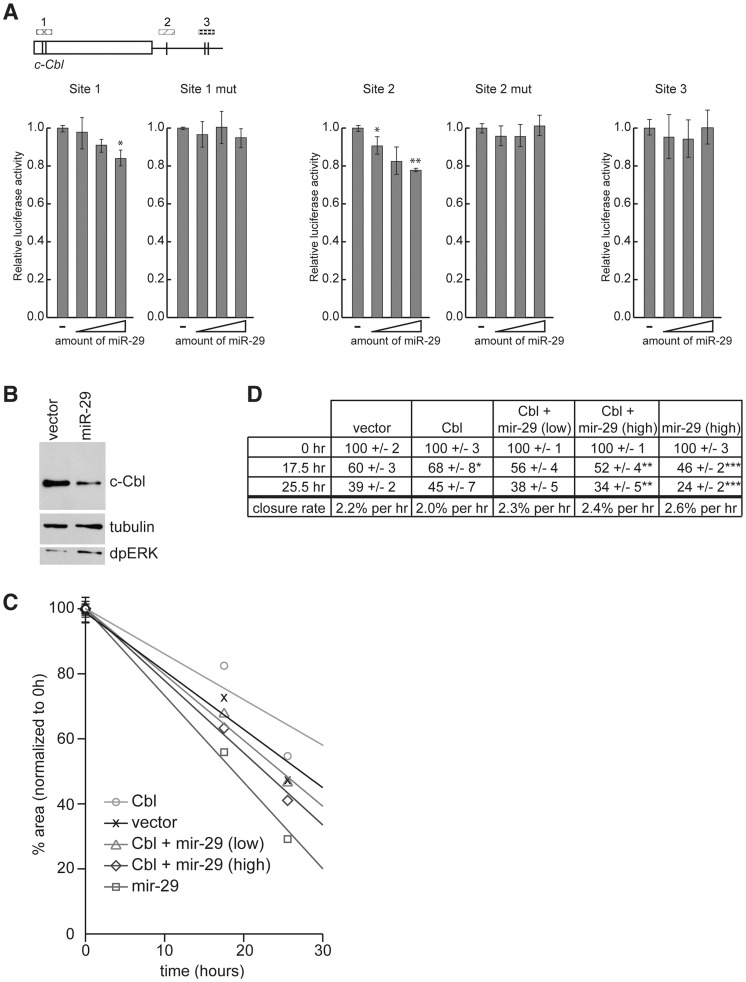
c-Cbl is a target of hsa-miR-29 in mammalian cells.(A) 3′ UTR sensor assays were performed in HeLa cells using sequences predicted to be regulated by miR-29. The indicated wild-type or mutant 3′ UTR sensor plasmids were transfected with pcDNA3/empty alone, or increasing amounts of pcDNA3/mir-29 plasmids. Cells were harvested 24–48 h post-transfection, and luciferase activities were measured. A minimum of three independent transfections was performed for each sensor construct. Error bars represent standard error. Asterisks are shown for differences between vector and miR-29 that are statistically significant by t-test (* is p<0.05, ** is p<0.01). (B) Cell lysates were prepared from HeLa cells transiently transfected with pcDNA3/empty or pcDNA3/mir-29 plasmids. The expression of c-Cbl, dpERK, and tubulin were detected by Western blot. (C and D) Wound healing assays were performed on HeLa cells transfected with c-Cbl, miR-29a, or an empty vector control. The area of the wound was measured at each time point and normalized to 0 h. Eight wound areas were measured for each sample at each time point. (C) Average wound areas relative to the initial scratch were plotted for each transfection condition. (D) Summary of scratch assay data. Shown are average wound area and standard error for each transfection condition, and the rate of wound closure (change in % scratch area/time) represented in (C) as trendlines. Asterisks are shown for differences between sample and vector control that are statistically significant by t-test (* is p<0.25, ** is p<0.15, and *** is p<0.005).